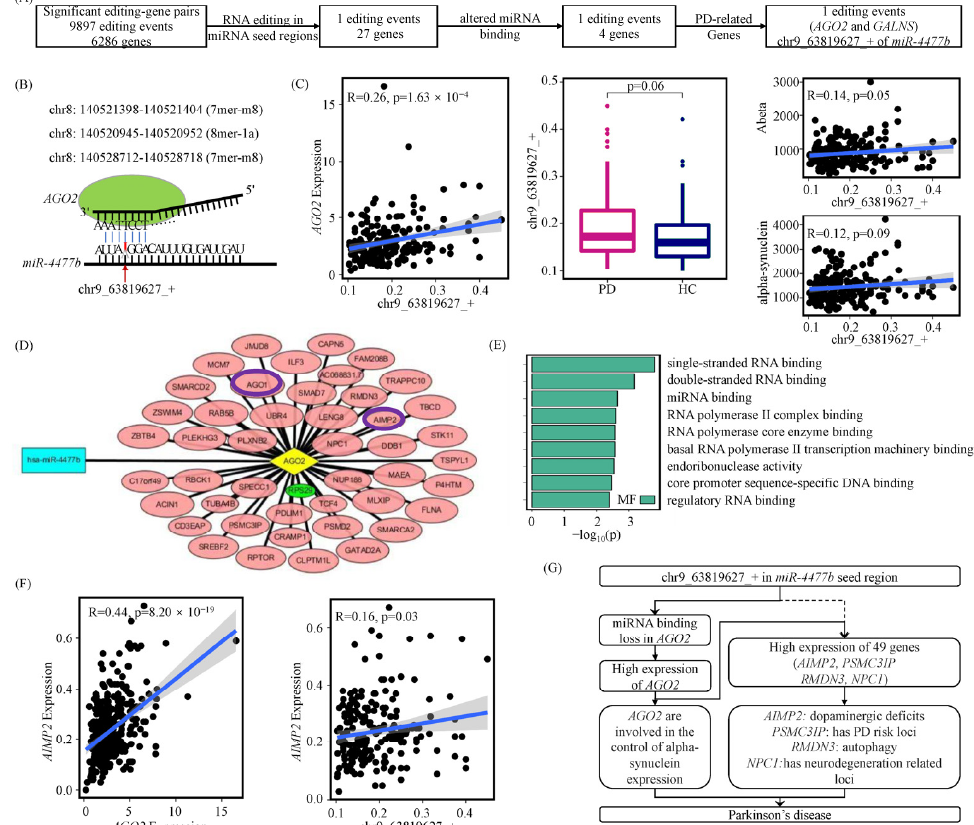
Figure 5. A-to-I RNA editing events may modify miRNA seed regions to disturb their regulations. ( A ) Analysis procedures to uncover the possible mechanisms for the associations between RNA editing events in miRNA seed regions and their targets. The editing example in miR-4477b is highlighted. ( B ) This RNA editing event alters the miRNA seed region, thus leading to the loss of miRNA binding on AGO2 . ( C ) The frequencies of this RNA editing event are positively associated with the expressions of AGO2 . The editing event shows higher frequencies in PD samples and positive associations with the levels of amyloid β -protein and α -synuclein. ( D ) The 46 AGO2 -interacted RNAs are significantly associated with AGO2 and the editing event. The red and green circles describe the positive and negative associations, respectively. ( E ) The associated genes are enriched in the regulations of miRNAs and RNA binding proteins by Enrichr. ( F ) One PD-related gene, AIMP2 , is positively associated with AGO2 and the editing event. ( G ) The analyses above may uncover the potential effects of this RNA editing event in miRNA seed region on five PD-related